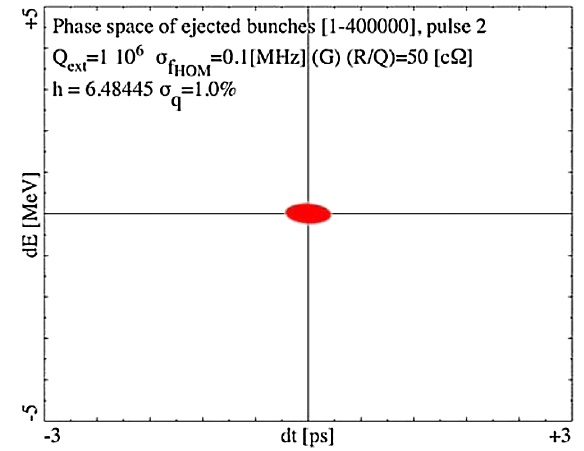
FIG. 12. (Color) Phase space identical to Figs. 8 and 11 (includ- ing same random numbers) but Q ext ¼ 10 6